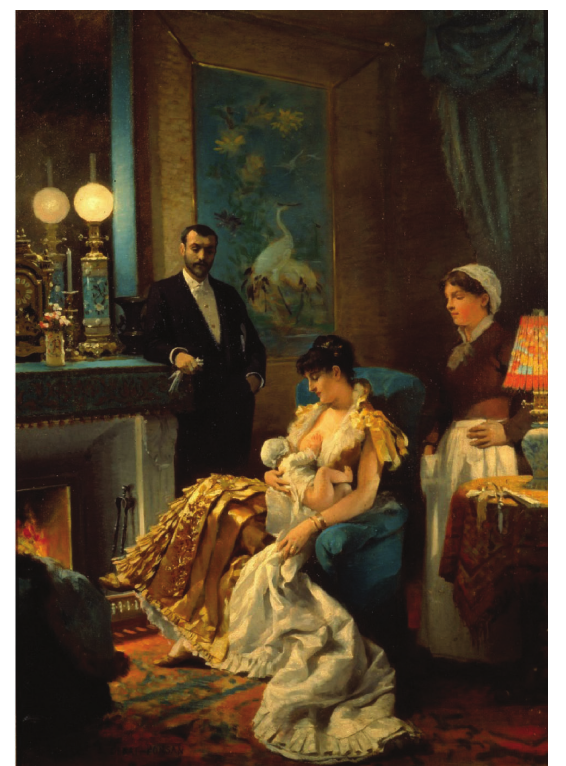
Picture D: Painting of a middle-class family by the fireplace, with a maid (1886, Avant le bal , painted by Edouard Debat-Ponsan)